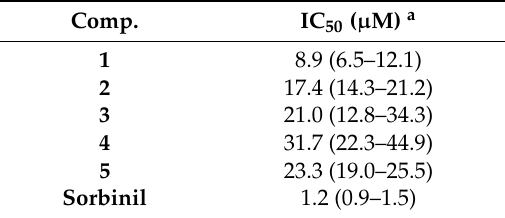
Table 2. Inhibition of human recombinant AKR1B1 by compounds 1 – 5. Comp.